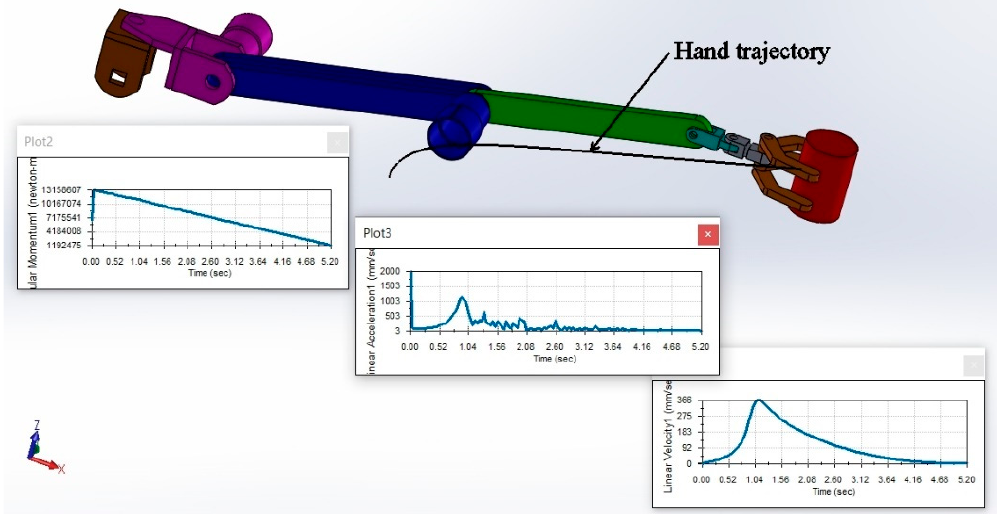
Figure 15. Robot arm simulation test for strategy and dynamic evaluation.